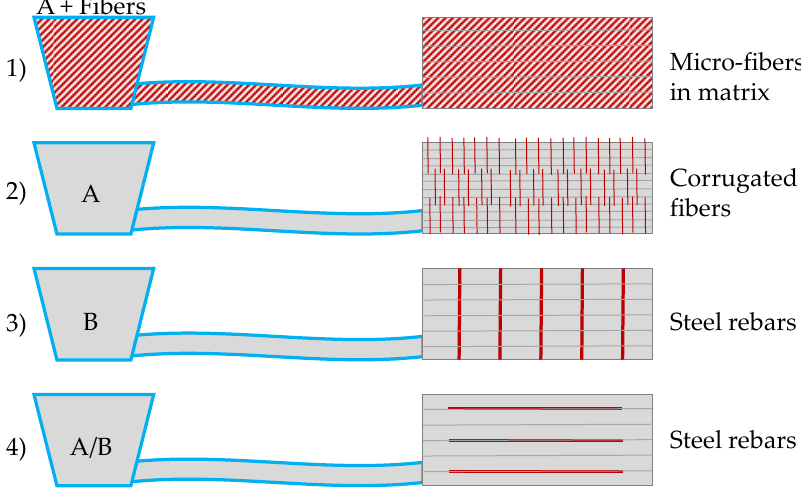
Figure 1. Schematical overview on experiments and reinforcement types.